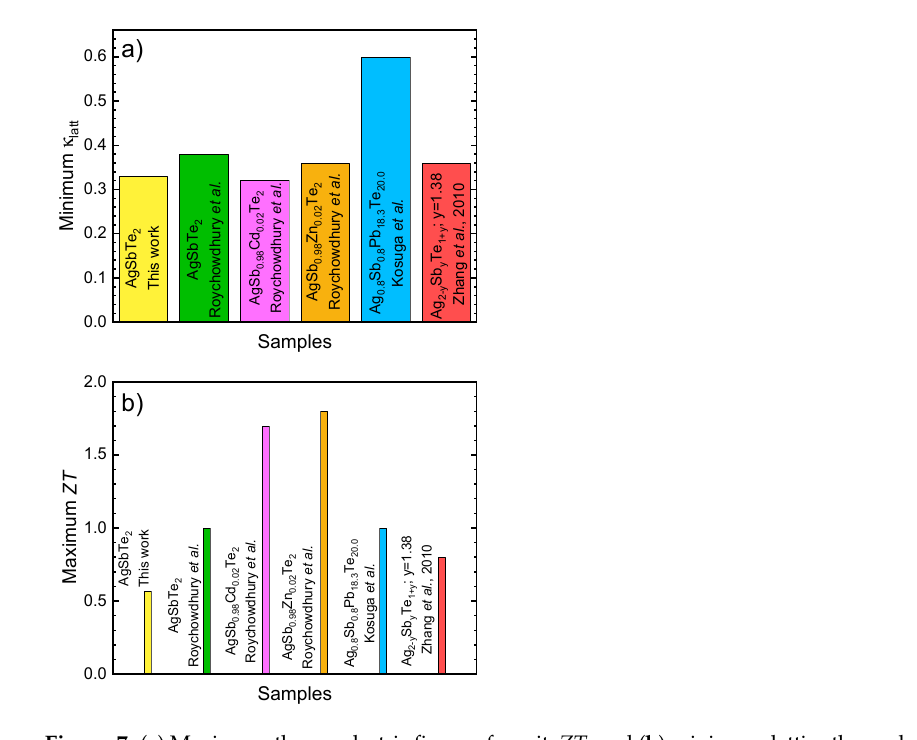
Figure 7. ( a ) Maximum thermoelectric figure of merit, ZT , and ( b ) minimum lattice thermal conductivity for several tellurides [31,61,67,68], compared with the composition analyzed in this work, AgSbTe 2 .